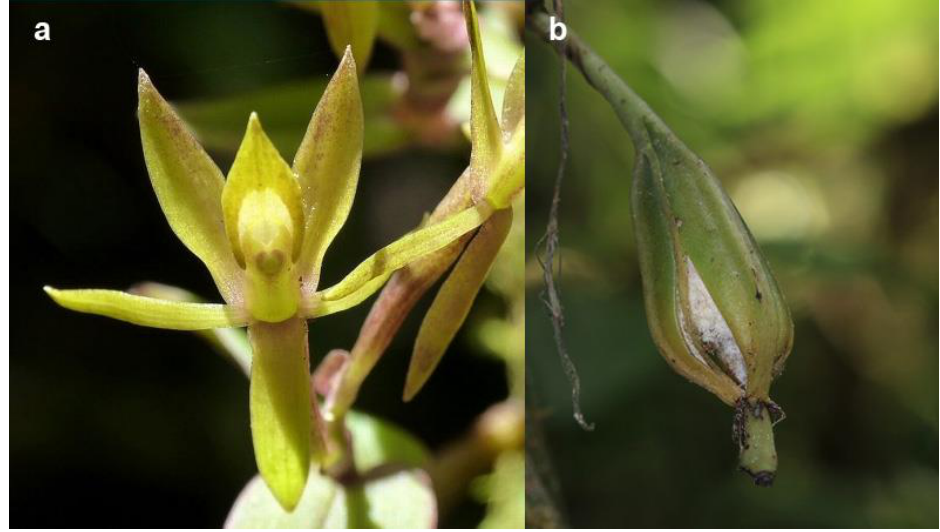
Figure 1. ( a ) Flower of Epidendrum geminiflorum and ( b ) open seed capsule collected in Cuyuja, Ecuador. Photo by Andreas Kay with permission.